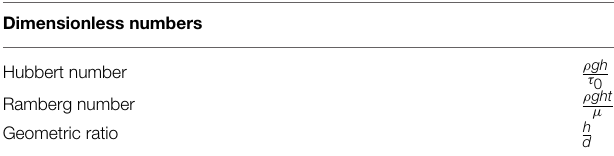
TABLE 2 | The Hubbert and the Ramberg dimensionless numbers (plus one geometric ratio) are enough to scale the example in Figure 1. Dimensionless